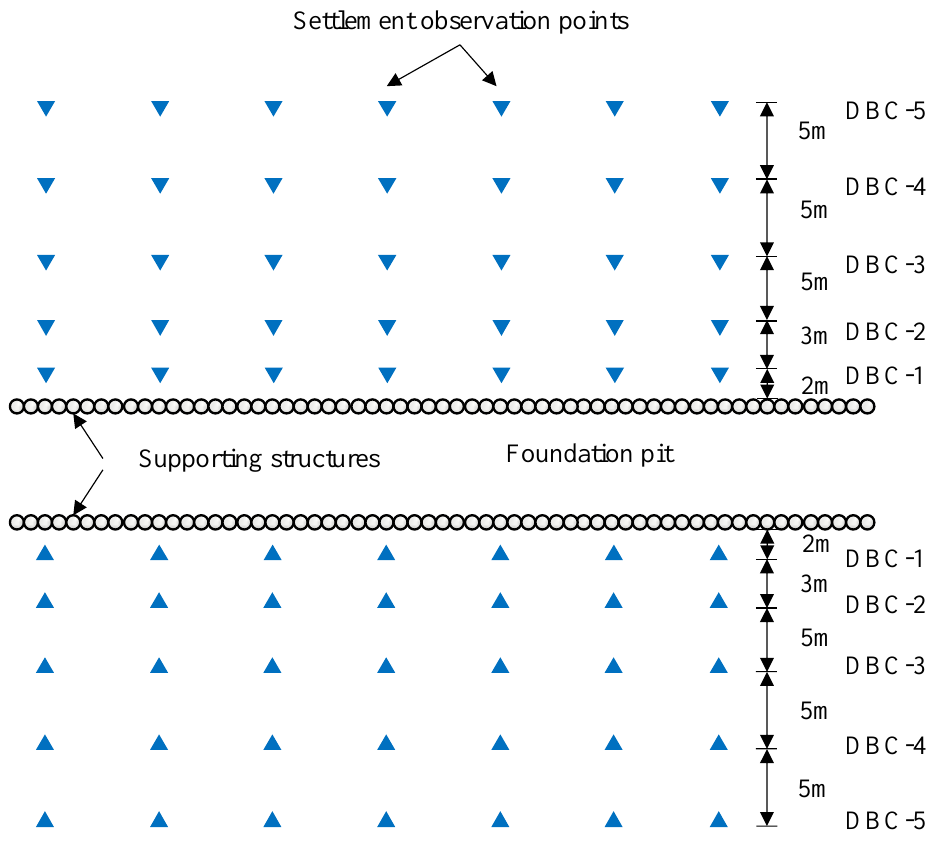
Figure 4. Locations of settlement observation points in the case study.